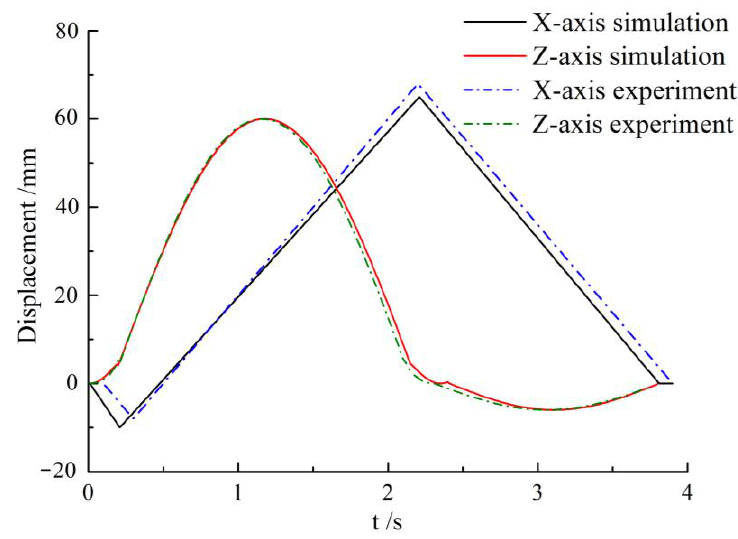
Figure 11. The foot end displacement.